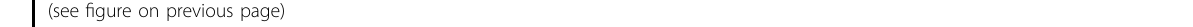
= − 3.23, p < 0.01, long bouts- t 42